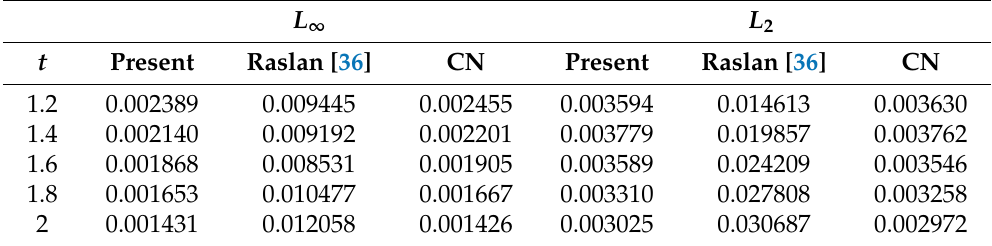
Table 2. Error norms at N = NT = 50, T f = 2.